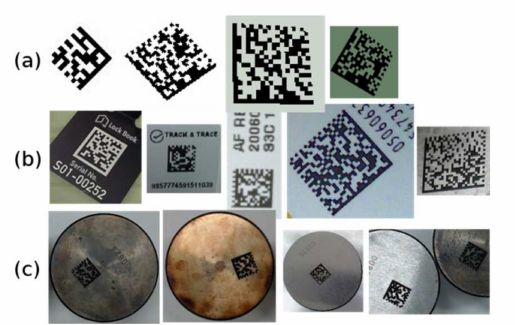
Figure 19. Testing samples: ( a ) synthetic; ( b ) Internet; ( c ) industrial.